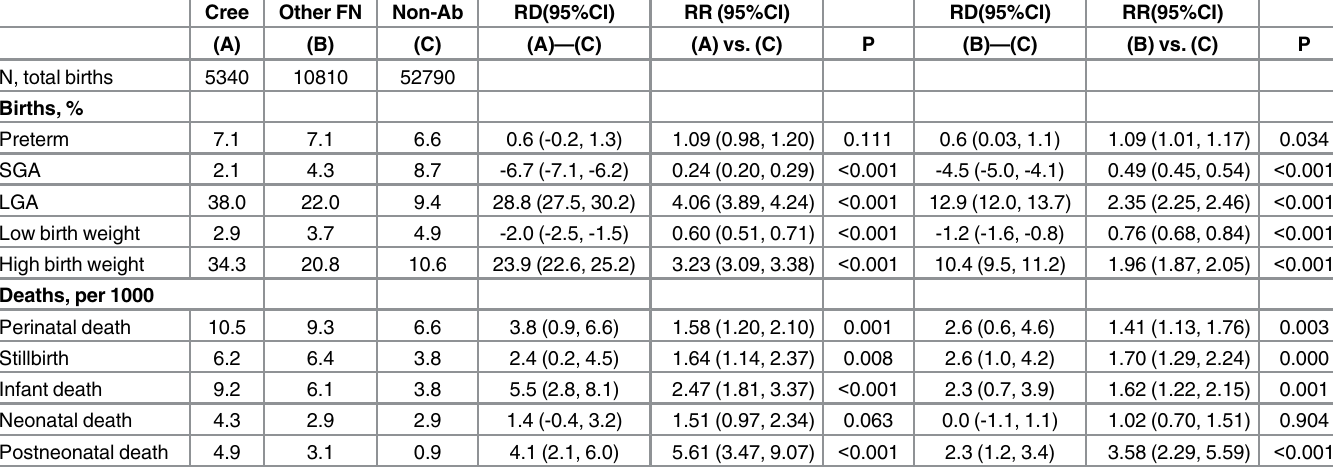
Table 4. Birth outcomes, perinatal and infant mortality in Cree, other First Nations and non-Aboriginal communities in rural areas, Quebec 1996 – 2010.